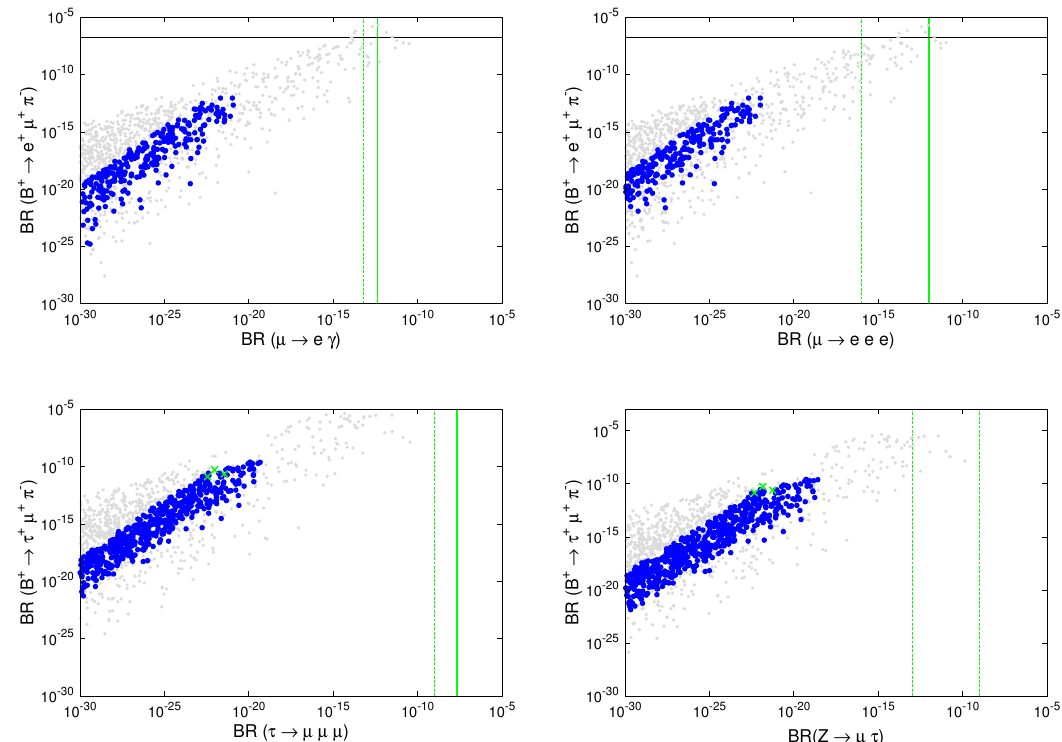
Figure 12 . Correlation between leptonic cLFV decays and LNV B -meson decays (into leptons of same or di(cid:11)erent (cid:13)avour). In each panel the vertical full (dashed) lines denote the current cLFV bounds (future expected sensitivity) of the corresponding leptonic decay. Grey points are excluded due to violation of at least one experimental or observational constraint (and by requiring c(cid:28) 4 (cid:20) 10 m), while the green crosses (present in the lower panels) denote points which are excluded due to excessive contributions to LNV